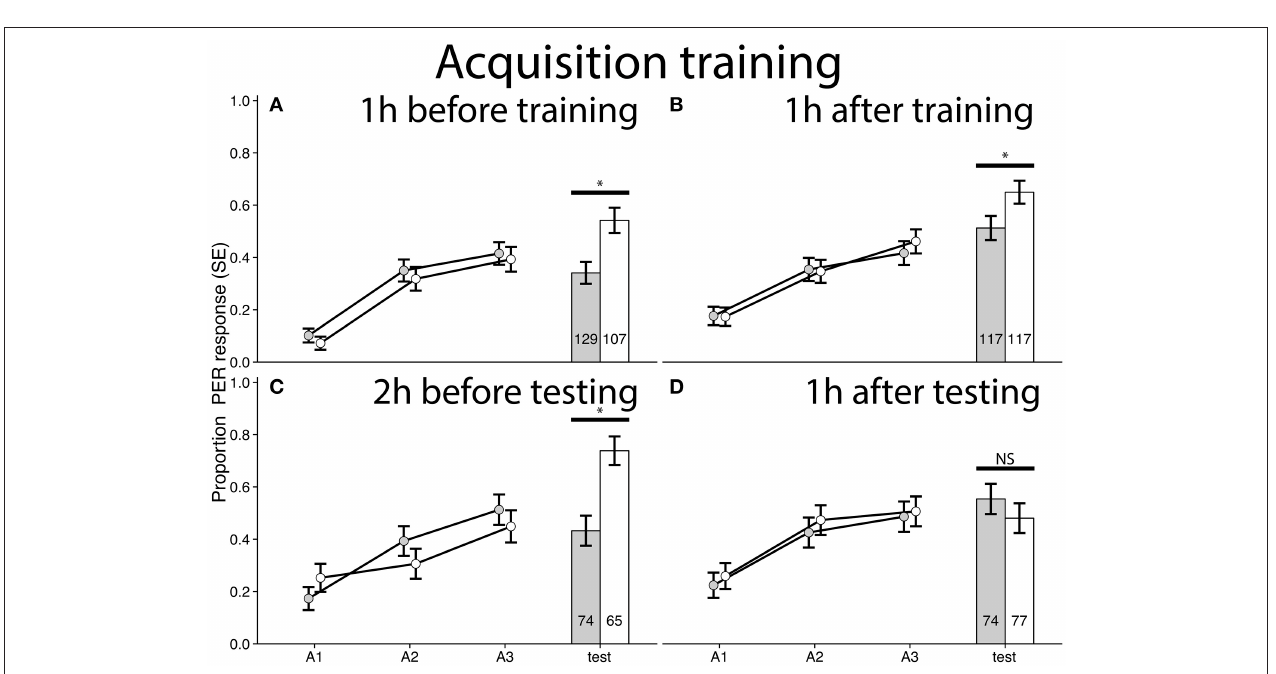
FIGURE 2 | Acquisition curves and test results for bees trained in a differential conditioning PER training paradigm. A1–A3 refers to each odor exposure during conditioning. Gray bars/dots represent bees treated with cocaine and controls are in white. Responses shown for the odor paired with sucrose reward, see Figure S1 for responses of the odor paired with NaCl. (A) Experiment 1: Bees treated with cocaine 1h before training ( χ 2 = 8.8245, p = 0.002972, n = 236, φ = 0.1933). (B) Experiment 2: Bees treated 1h after training ( χ 2 = 3.9503, p = 0.04686, n = 234, φ = 0.1299). (C) Experiment 3: Bees treated 2h before testing ( χ 2 = 12.043, p = 0.0005, n = 139, φ = 0.2943). (D) Experiment 4: Bees treated 1h after testing ( χ 2 = 0.5491, p = 0.4587, n = 151). *Denotes statistically significant differences.